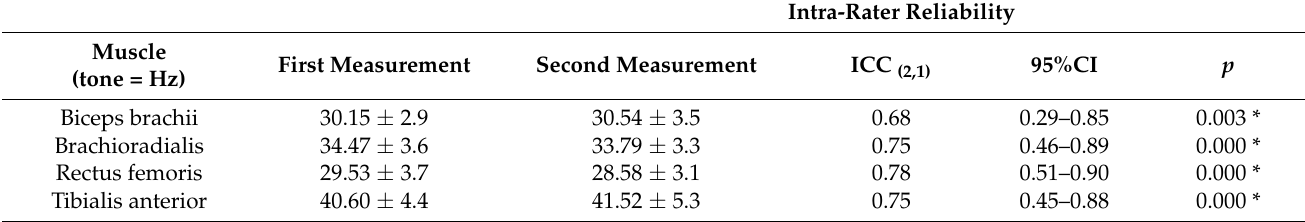
Table 2. Intra-rater reliability of the myotonometer in the measurements of muscle